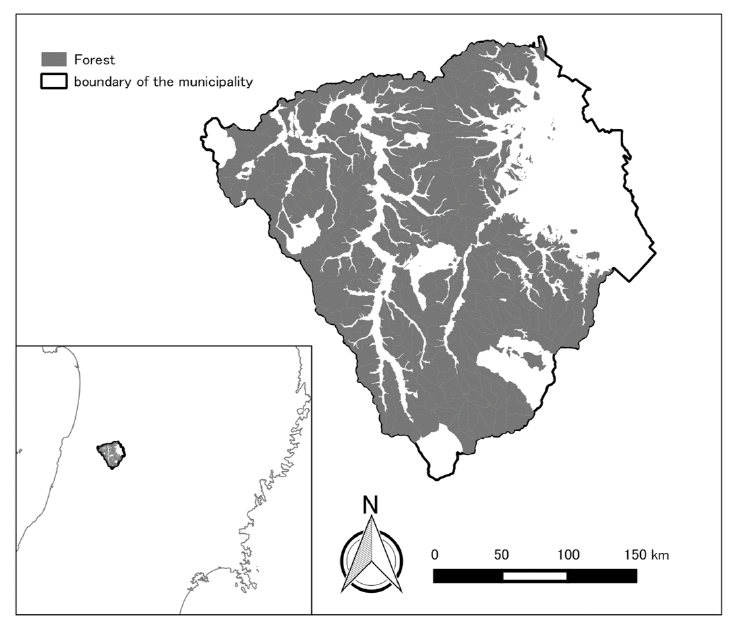
Figure 3. Location of the study area, Ugo, Akita prefecture in the Tohoku district of Japan.